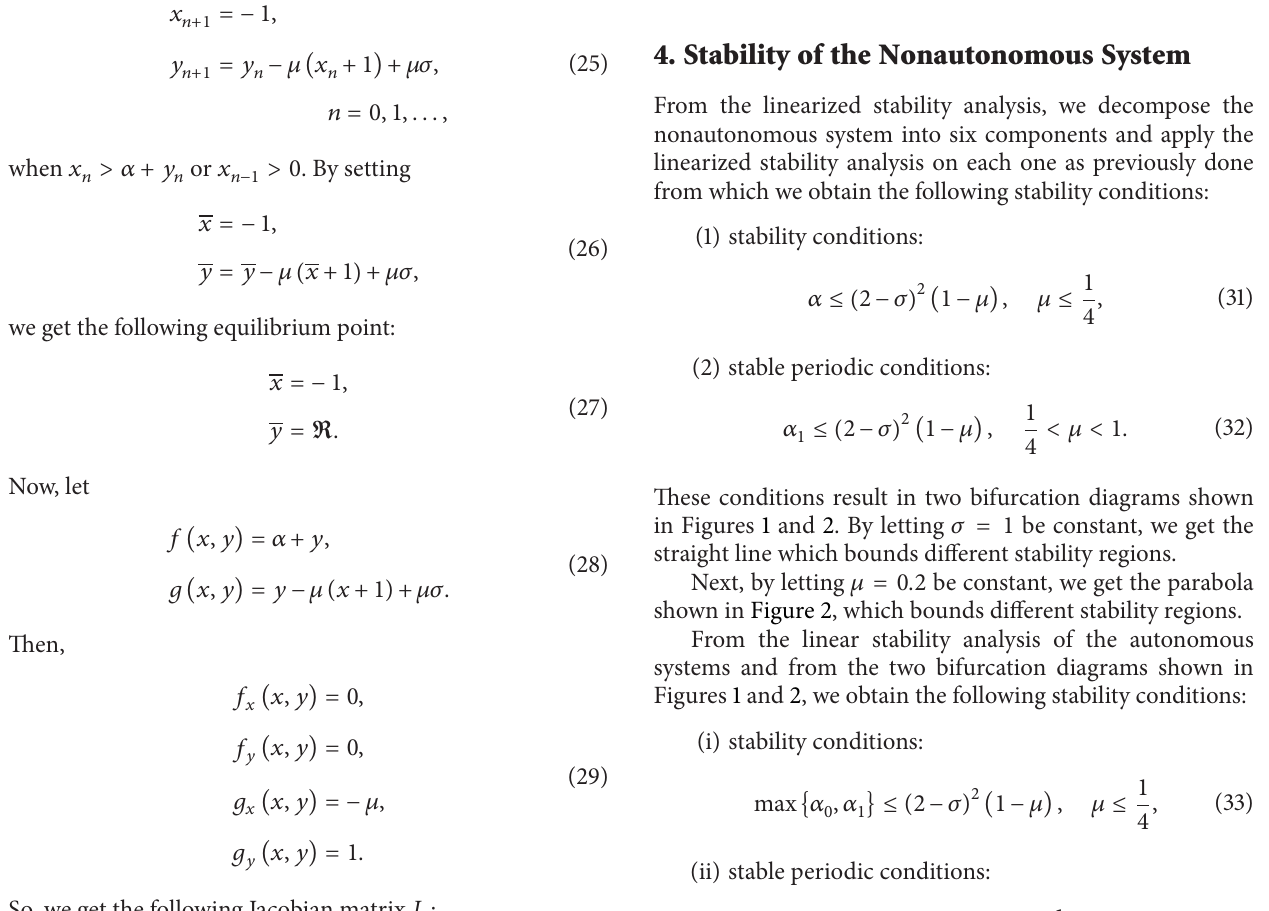
Figure 1: Bifurcation diagram with 𝜇 as a control parameter for 𝜎 =